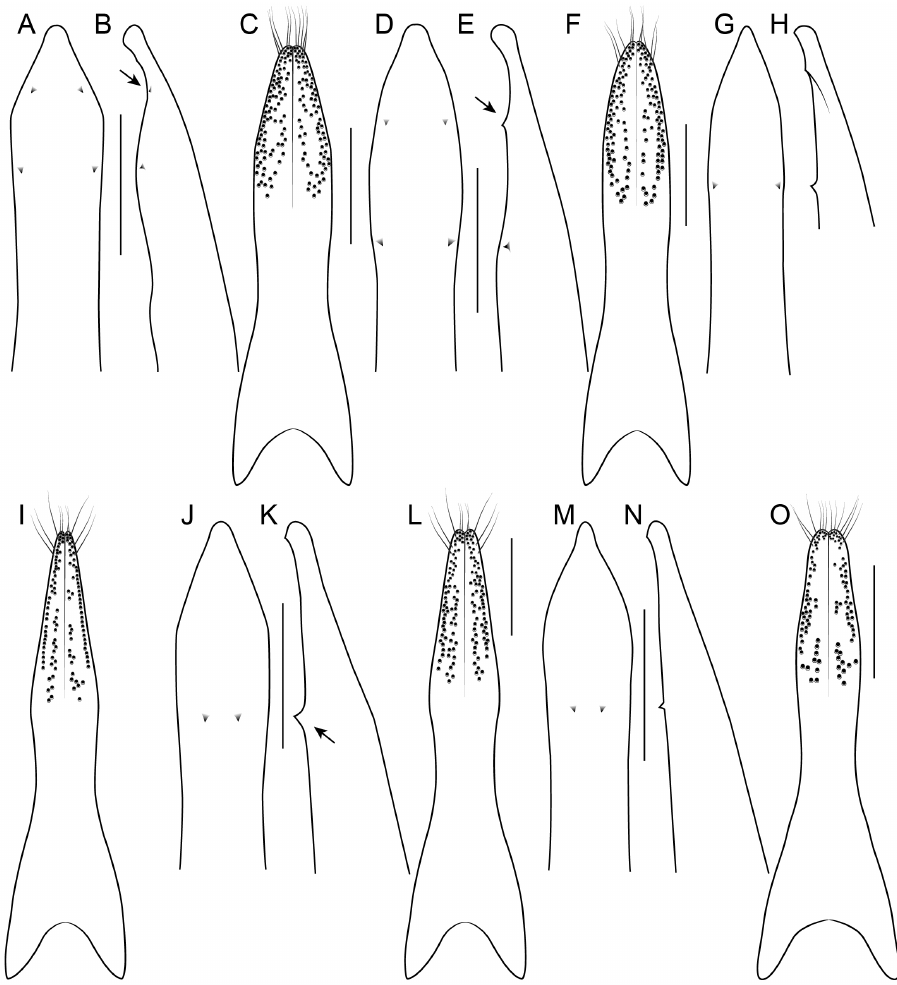
Figure 11. Bolitogyrus carnifex (Fauvel) ( A–C ), B. pederseni Brunke ( D–F ), B. vietnamensis (Scheerpeltz) ( G–I ), B. elegantulus Yuan et al. ( J–L ) and B. phukhieo Brunke ( M–O ). Median lobe in parameral view ( A, D, G, J, M ), median lobe in lateral view ( B, E, H, K, N ), peg setae of paramere ( C, F, I, L, O ). Scale bars: 0.5